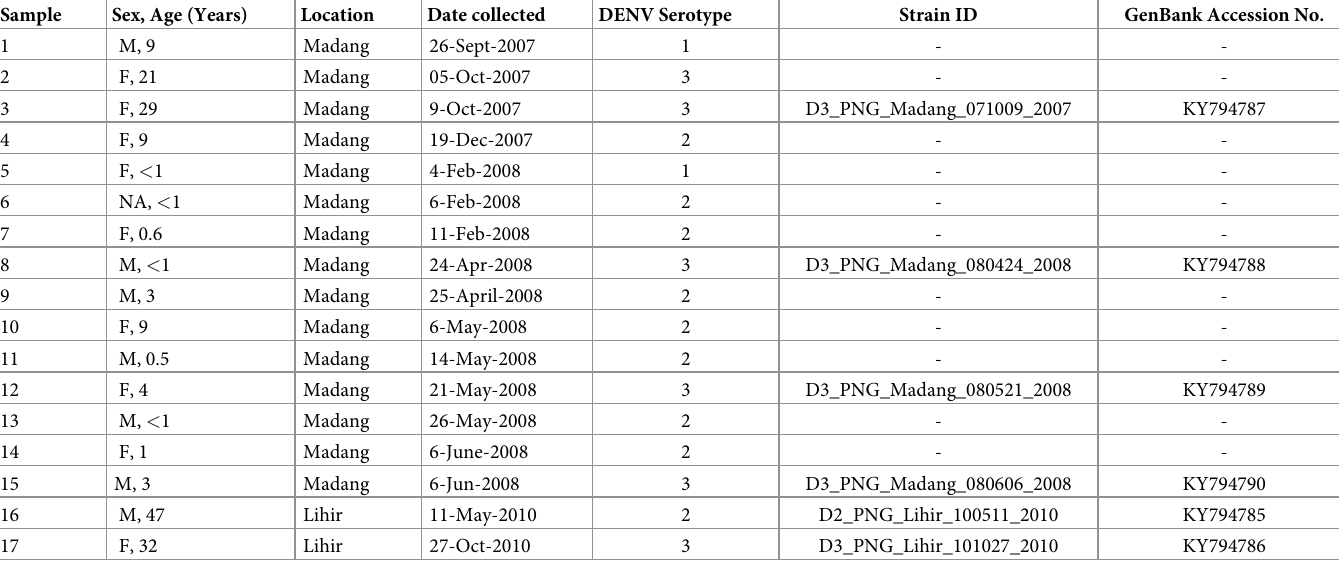
Table 2. DENV identified in febrile patients,